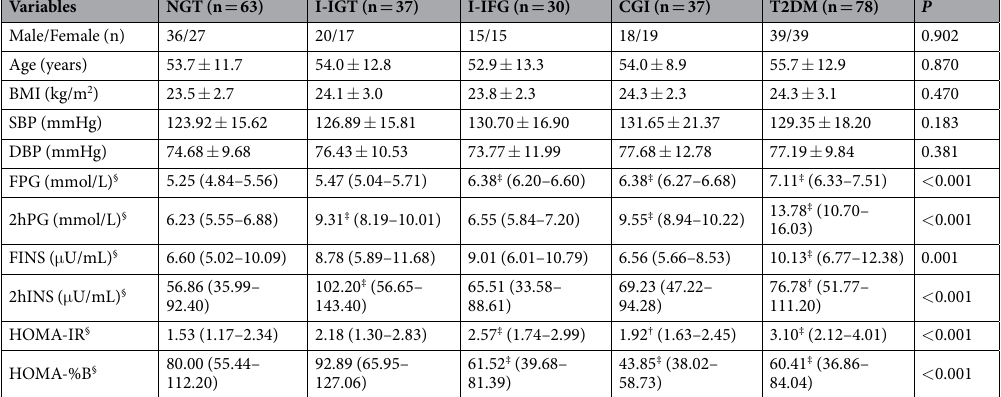
Table 1. Anthropometric parameters and biochemical indexes among study subjects (n = 245). Data are mean ± SD or median (interquartile range). § Log transformed before analysis. CGI, combined glucose intolerance; DBP, diastolic blood pressure; FINS, fasting serum insulin concentration; FPG, fasting plasma glucose concentration; HOMA-%B, homeostasis model assessment of insulin secretion; HOMA-IR, homeostasis model assessment of insulin resistance; I-IFG, isolated-impaired fasting glucose; I-IGT, isolated- impaired glucose tolerance; NGT, normal glucose tolerance; 2hPG, 2-h plasma glucose concentration; SBP, systolic blood pressure; T2DM, type 2 diabetes mellitus; 2hINS, 2-h serum insulin concentration; † P < 0.05, compared with NGT; ‡ P < 0.01, compared with